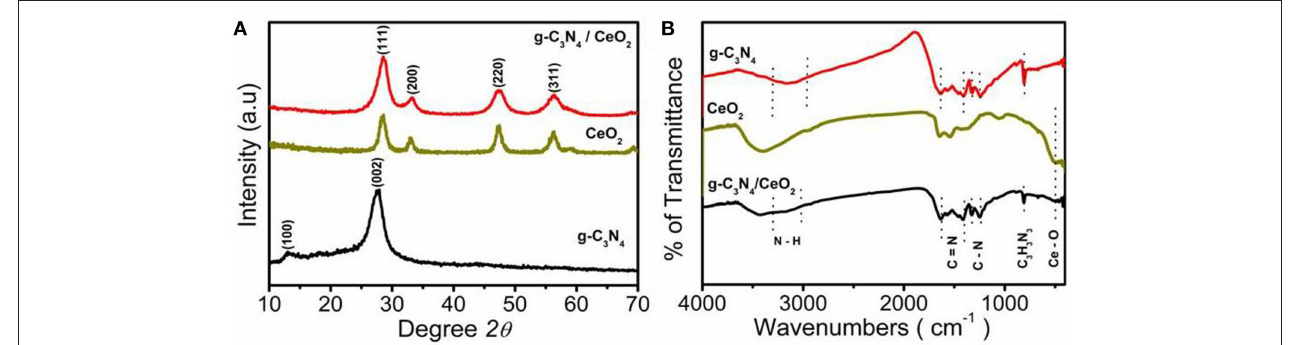
FIGURE 2 | (a) TEM, (b) HRTEM at 10nm, (c) SAED, and (d) HRTEM at 1nm of CeO 2 /g-C 3 N 4 .